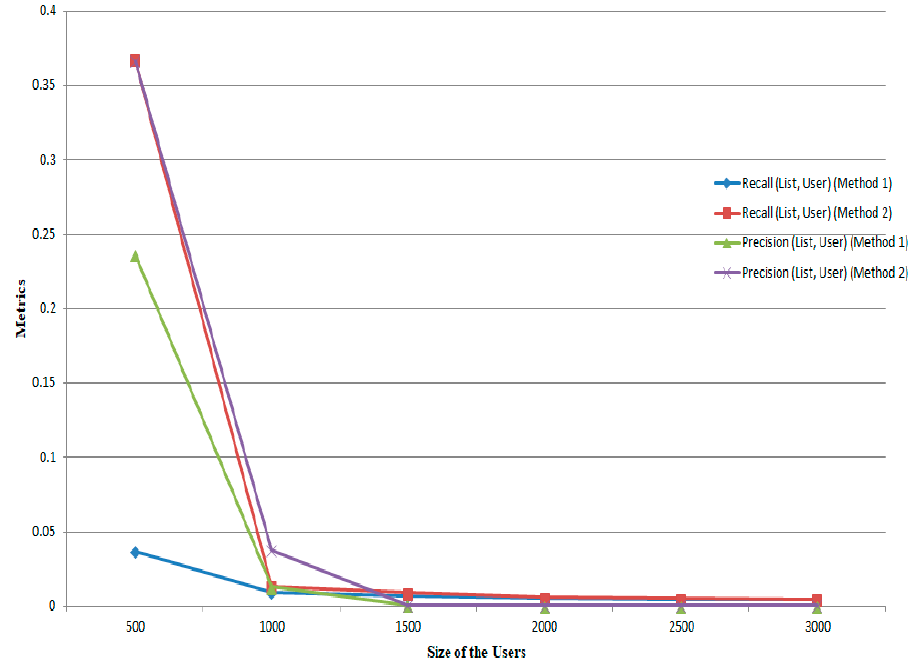
Figure 10. Sizes of the Users versus Precision & Recall Metrics for Book-Crossing .